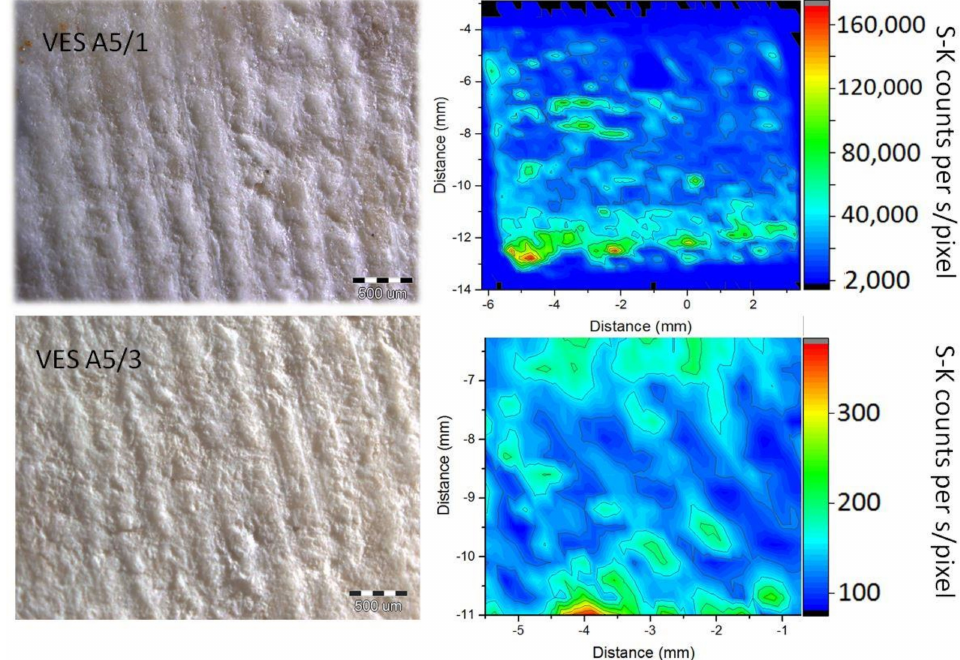
Figure 4. Right: 2D S-K XRF map from the surface of the Veselje limestone treated with AmOx brushing for 1 h ( up ) and 3 h ( down ) after exposure to sulfuric acid. Left: photomicrograph of related